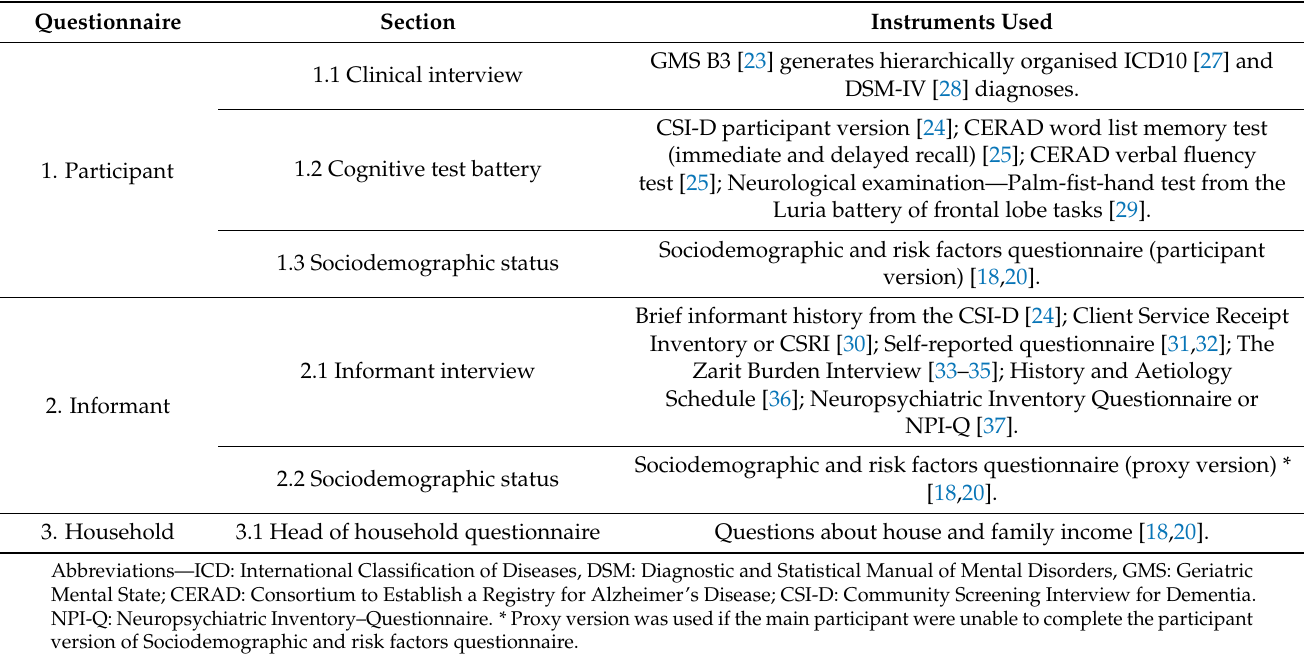
Table 1. Sections of the 10/66 dementia